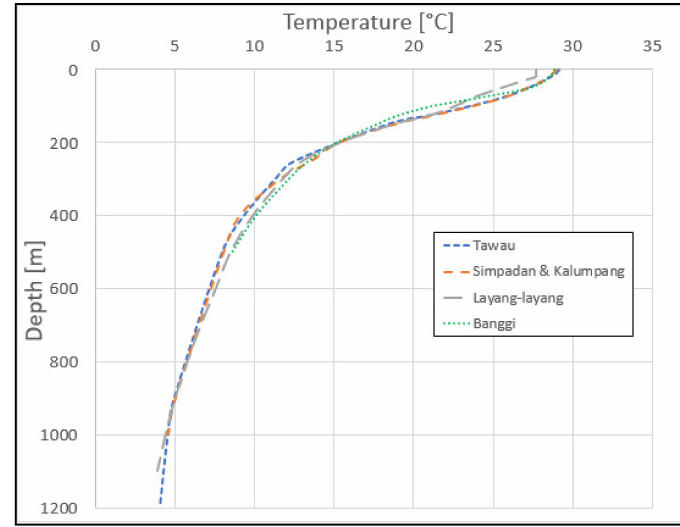
Figure 3. Deep seawater temperature and depth profiles of Tawau, Simpadan, Pulau Kalumpang, Pulau Layang-layang and Pulau Banggi; data obtained from the online Japan Oceanographic Data Center (JODC).